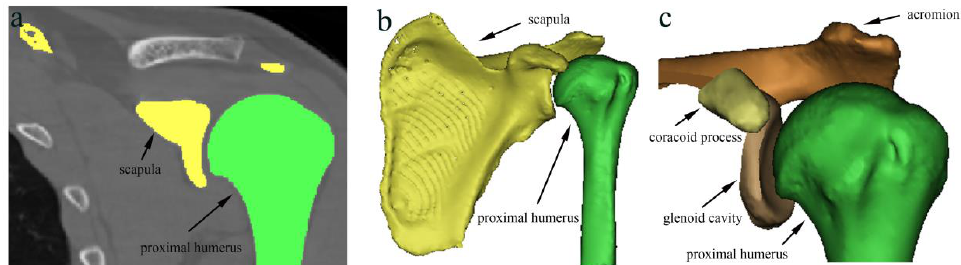
Figure 3. Representative 3D surface models reconstruction and segmentation of CT images of the proximal humerus and scapula. ( a ) Preparation of the proximal humerus and scapula for reconstruction on CT images. ( b ) Bone surface model of the scapula and proximal humerus. ( c ) The 3D surface models of the proximal humerus, acromion, coracoid process, and glenoid cavity. (Not-to-scale).